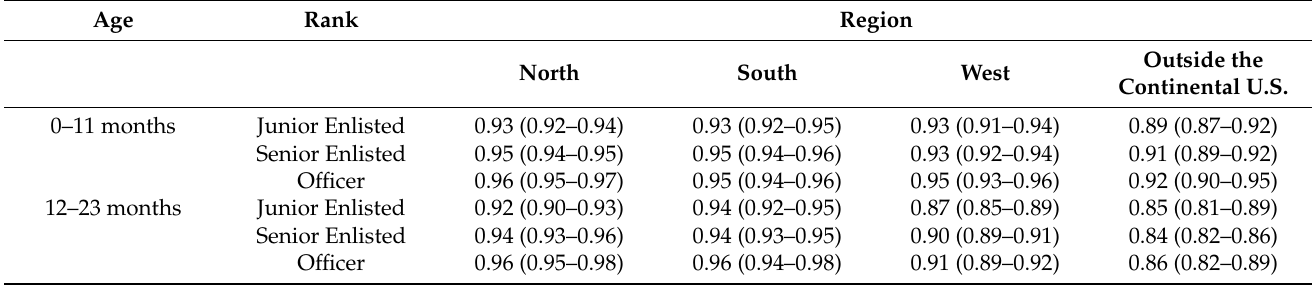
Figure 2. Well-Child Visit Rate by Demographic Category: Rates of well-child visits are reported per 1000 enrollees under 24 months of age by ( A ) Age by ( B ) Sex by ( C ) Rank and by ( D ) Geographic Region of the Military Health System. Table 4. COVID-19 versus Pre-COVID-19 Period Rate Ratios for Well-Child Visits Stratified by Table 3. -Well-Child Visit Rate Ratios (RR). Demographic